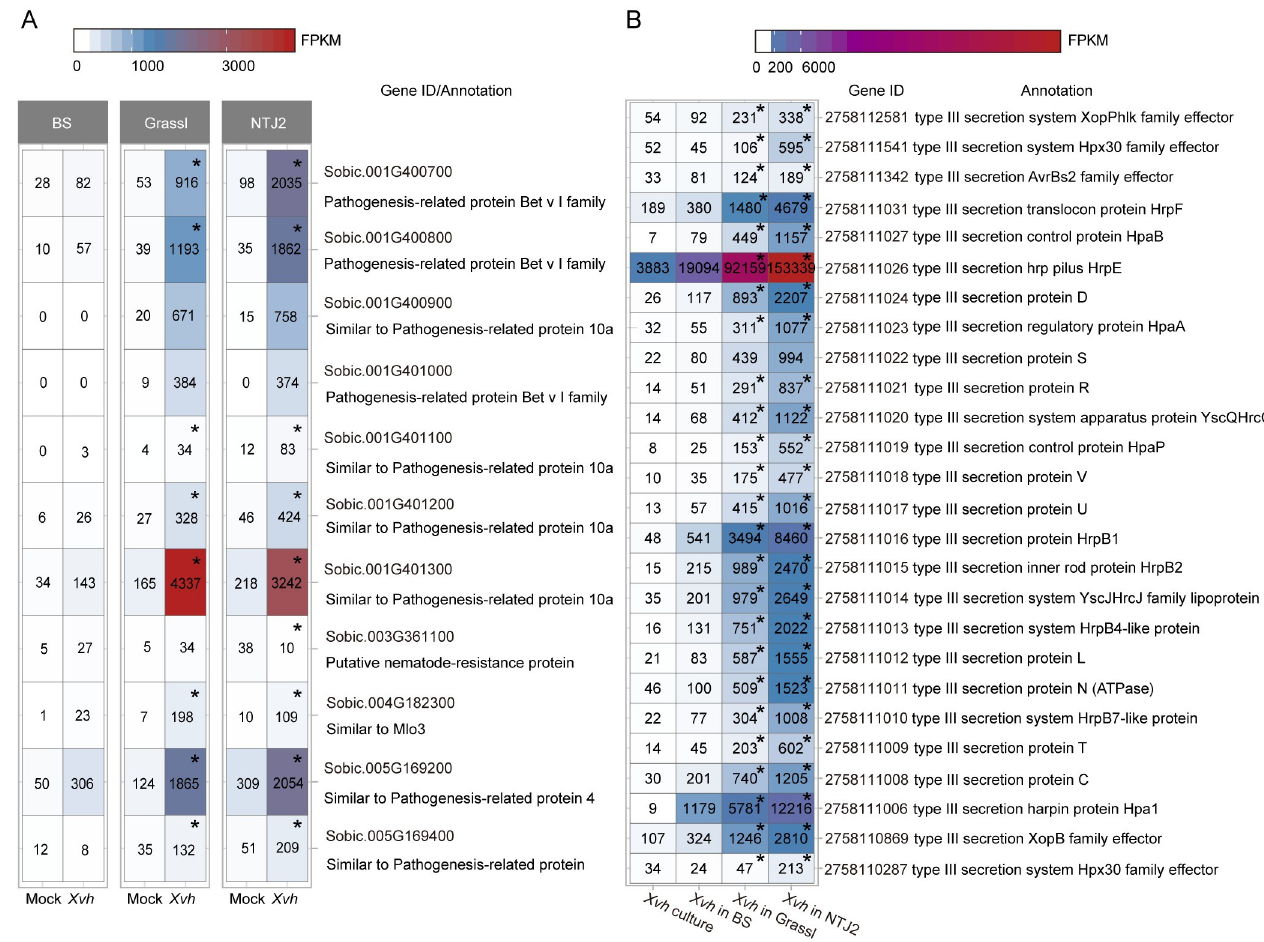
Fig 9. Expression patterns for genes associated with defense and virulence. A) Heatmap showing the expression of defense-related genes in sorghum. These genes were identified based on the associated GO term–defense response. B) Heatmap showing the expression profile of virulence-related genes from Xvh . Xvh genes related to the T3SS and T3 effectors based on annotation were used in this analysis. The values represent the average of FPKM (fragments per kilobase per million mapped sequence reads) of three replicates for each condition. Asterisks in (A) and (B) indicate significant differential expression (FDR adjusted p value < 0.01) as compared to Xvh infected BS and Xvh in BS, respectively. BS (water-soaked lesions), Grassl (red lesions), and NTJ2